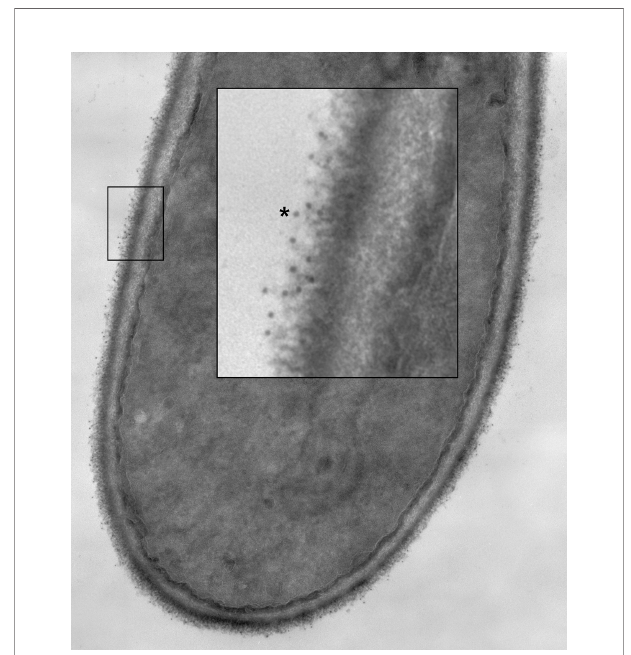
FIGURE 2 | A C. albicans HWP1/HWP1 germ tube labeled with anti-Hwp1 MAb 2-E8 and a secondary anti-mouse, gold-conjugated antibody. Gold particles, marking the location of Hwp1, appeared in the micrograph as small, electron-dense dots distributed over the outermost surface of the germ tube. A portion of the image was enlarged (inset) to better visualize the gold particles. One gold particle was marked with an asterisk and over a dozen others were visible in the enlarged